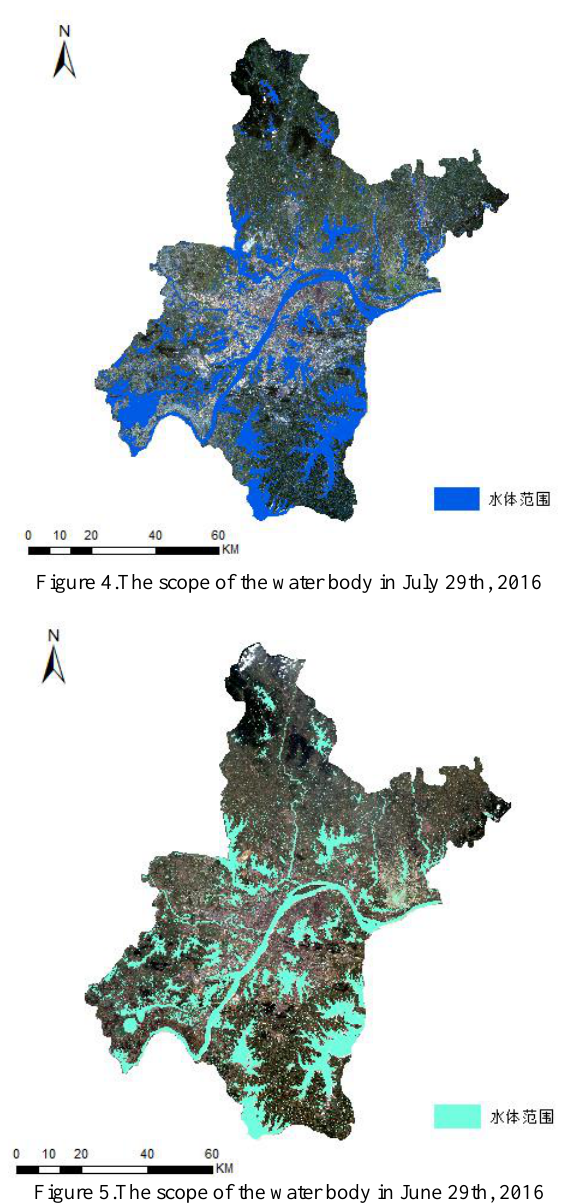
Figure 5.The scope of the water body in June 29th,